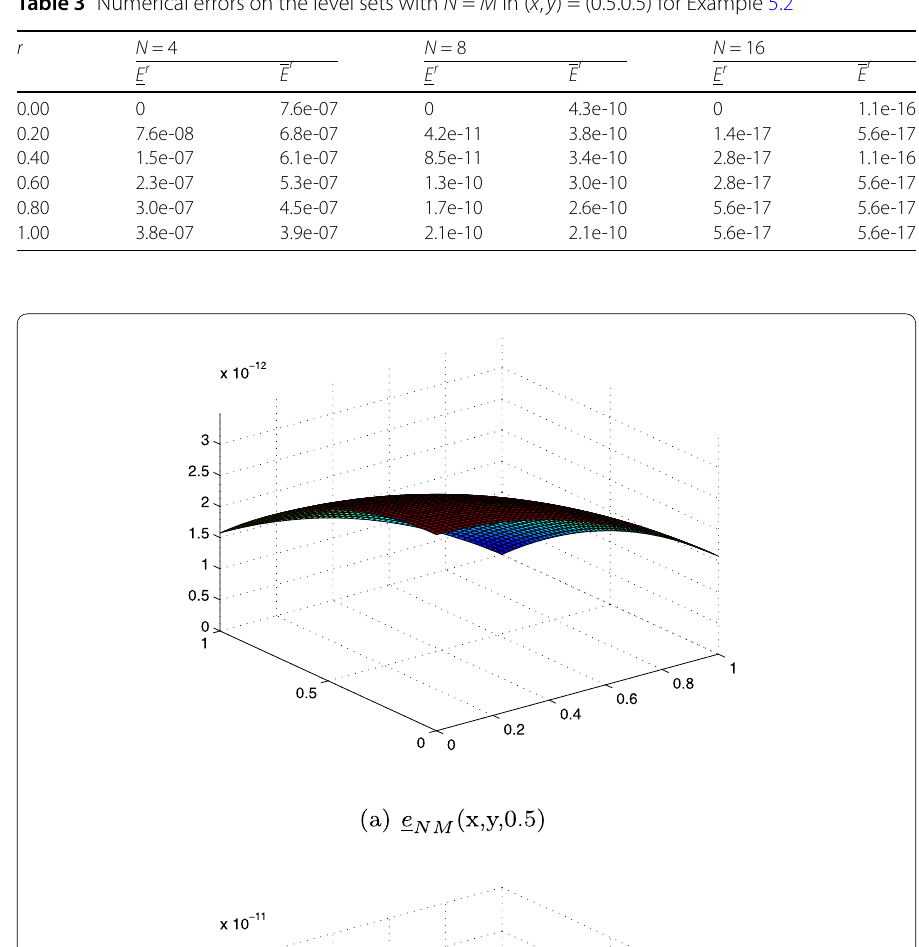
Figure 4 Numerical errors with N = 10 of Example 5.2